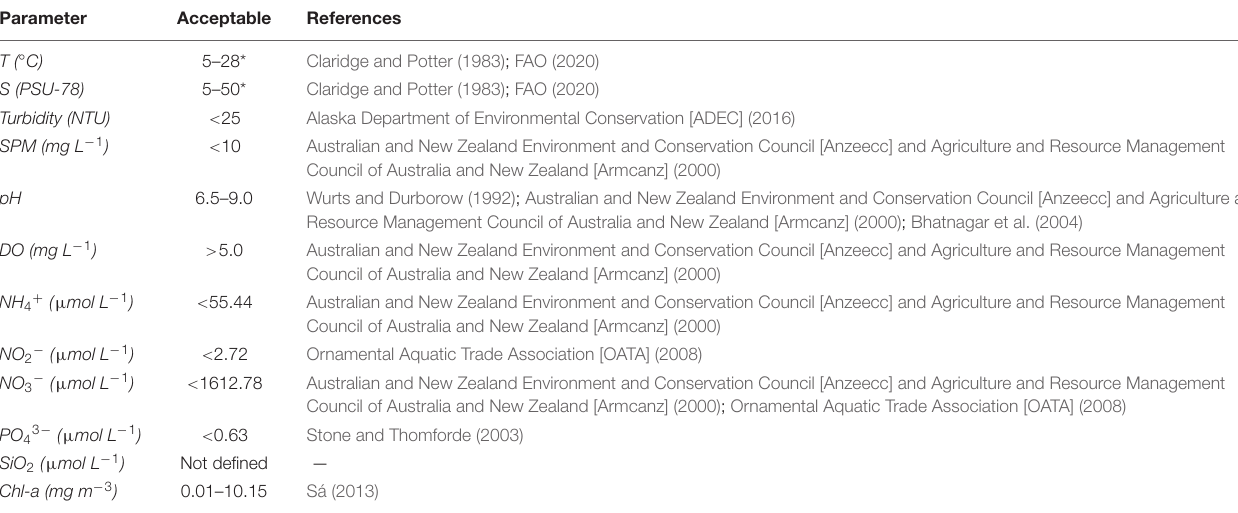
TABLE 1 | Acceptable water quality parameters for marine finfish